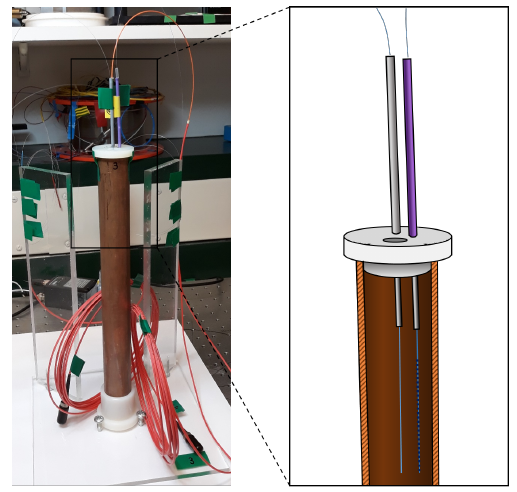
Figure 8. Photograph and sectional drawing of the test